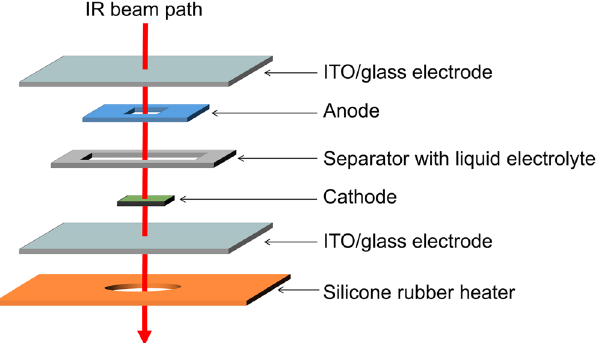
Figure 6. Schematic representation of the optical electrochemical cell for in situ IR